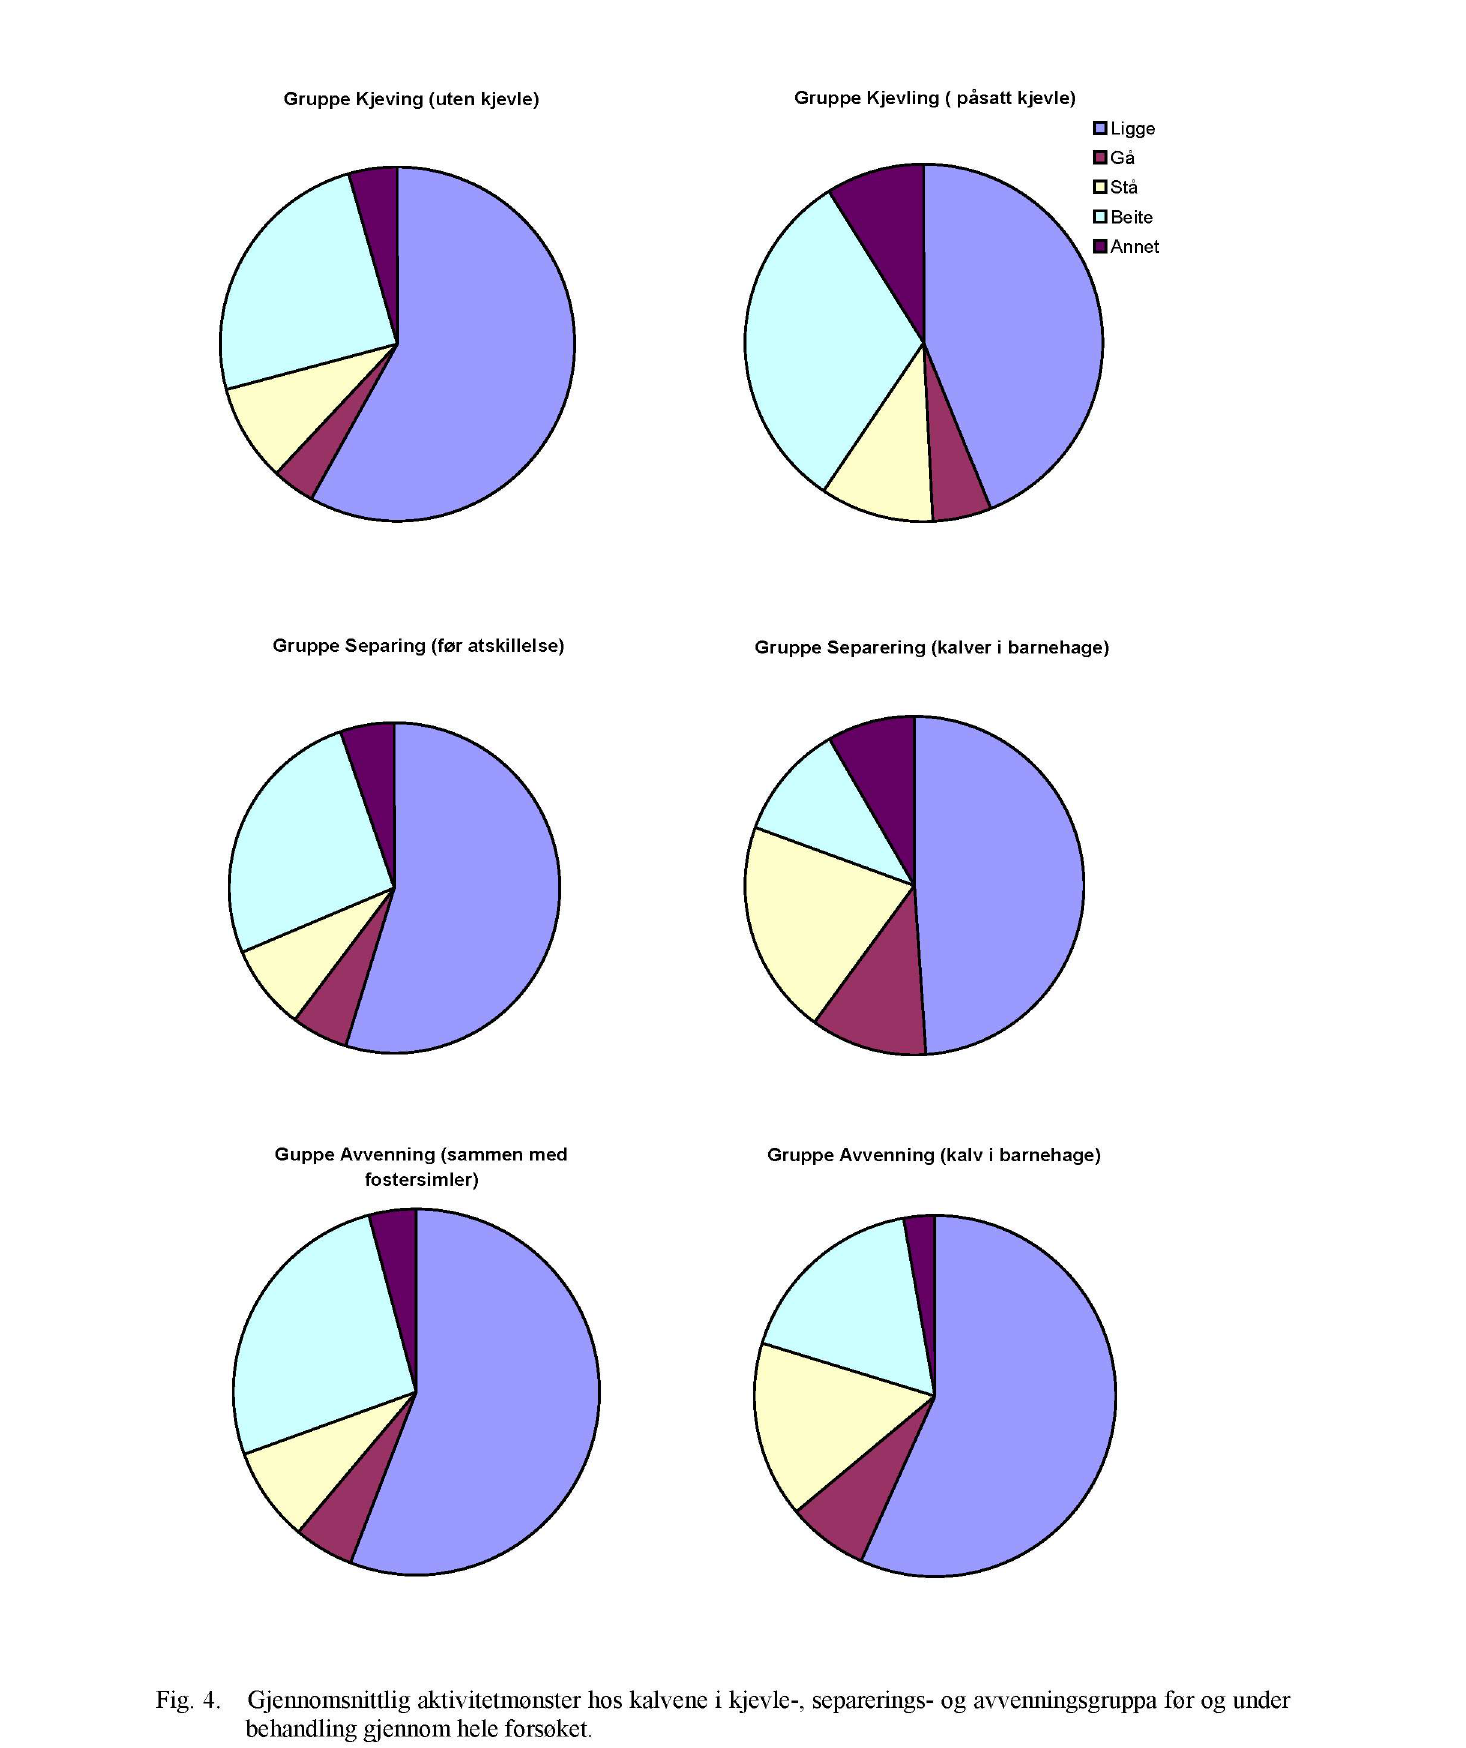
Fig. 4. Gjennomsnittlig aktivitetmønster hos kalvene i kjevle-, separerings- og avvenningsgruppa før og under behandling gjennom hele